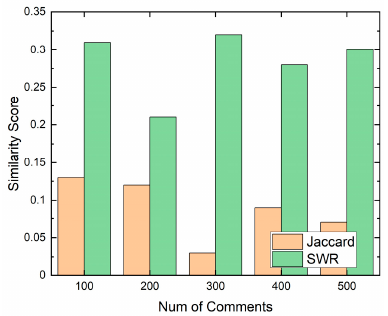
Figure 7. Similarity Score using